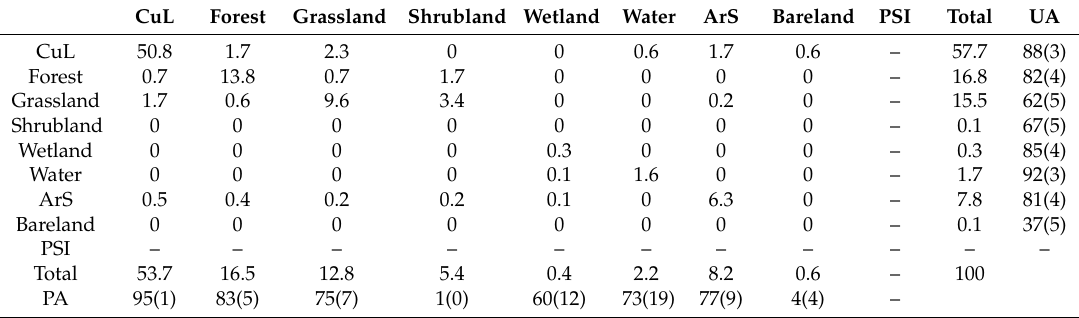
Table A8. The error matrix of estimated area proportions for R8: Overall accuracy is 82.4% (2.2%).